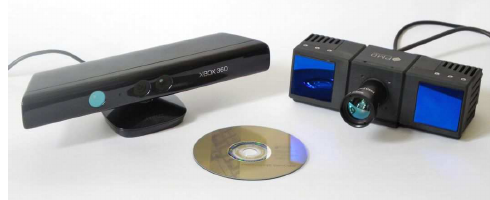
Figure 2. Range imaging devices: Microsoft Kinect (left) and PMD[vision] CamCube 2.0 (right).